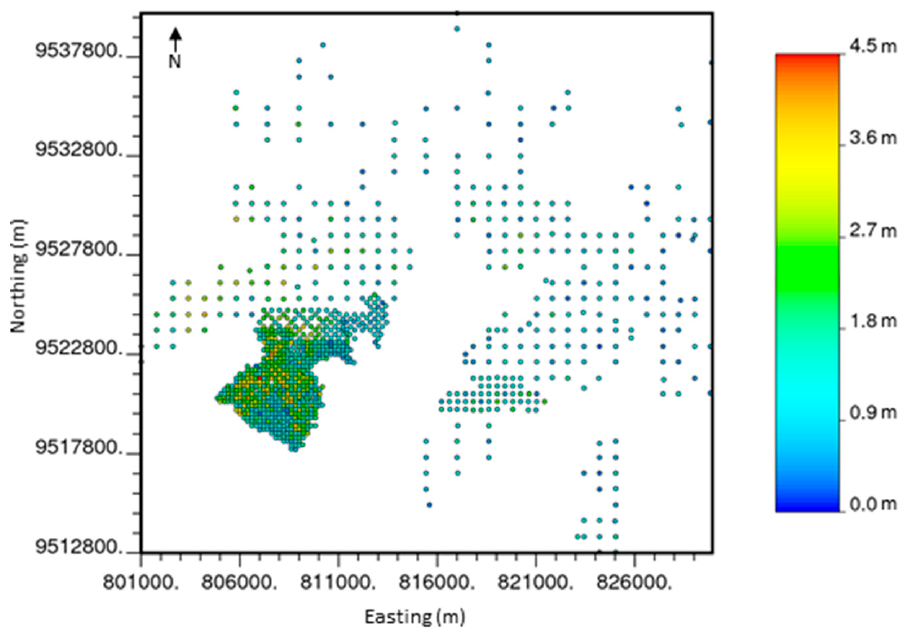
Figure 3. Location of drillholes with thickness data.